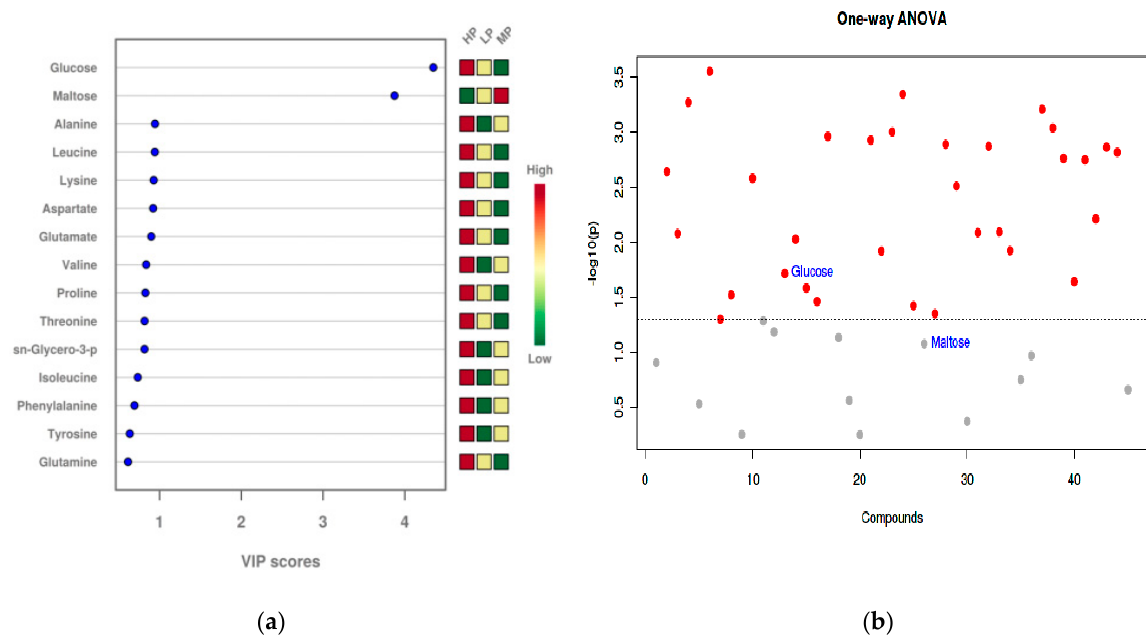
Figure 10. Metabolites variable importance of projection (VIP) Analysis and ANOVA test of metabolites (VIP > 1) in liver. ( a ) Metabolites VIP Analysis; ( b ) one ‐ way ANOVA test of metabolites (VIP > 1). Metabolites above the dotted line had significant differences.